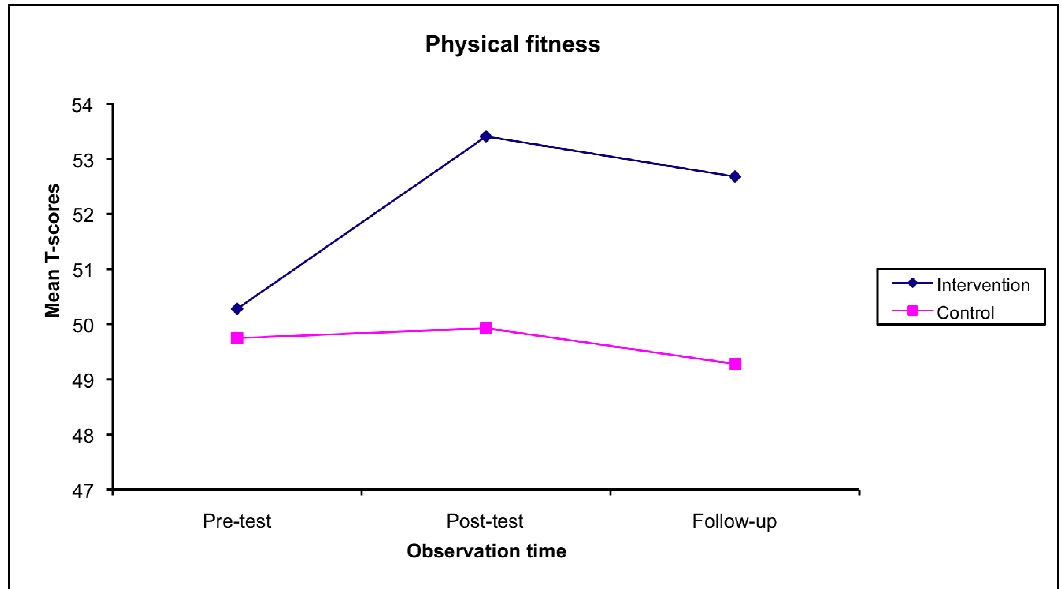
Mean total test T-scores of the EUROFIT physical fitness test for both intervention and control group with AS (n =